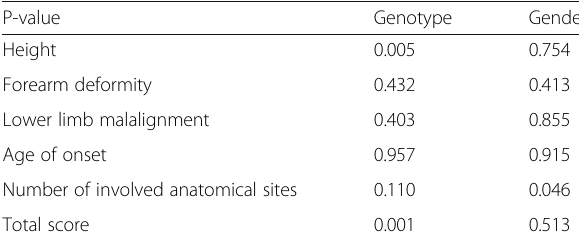
Table 4 Comparison of clinical features for patients according to genotype and gender